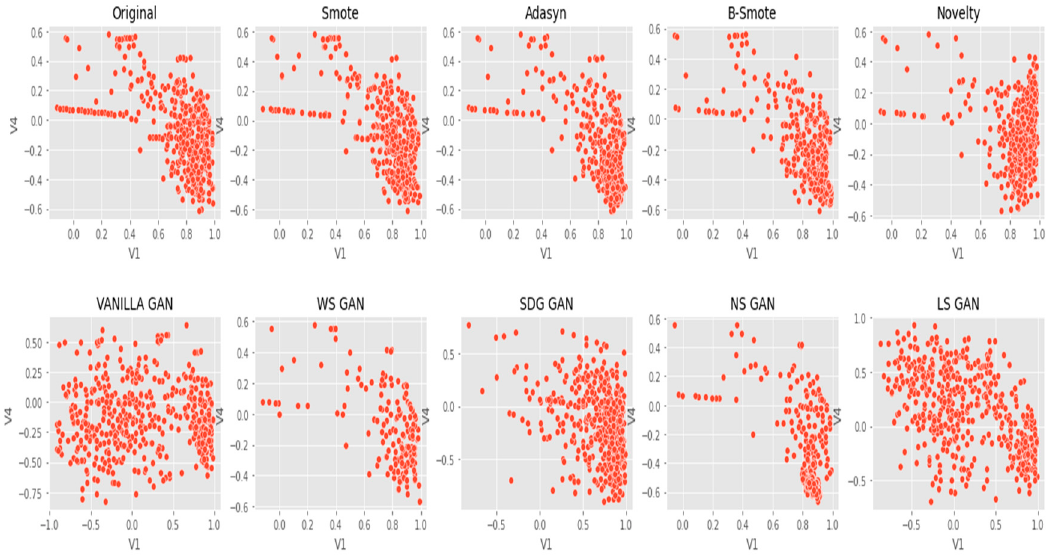
Figure 18. Bivariate V1 vs V4 Feature Distribution comparison of Original Data, SMOTE, ADAYSN, B‑SMOTE, Novelty K‑CGAN, Vanilla GAN, WS GAN, SDG GAN, NS GAN, and LS GAN methods.